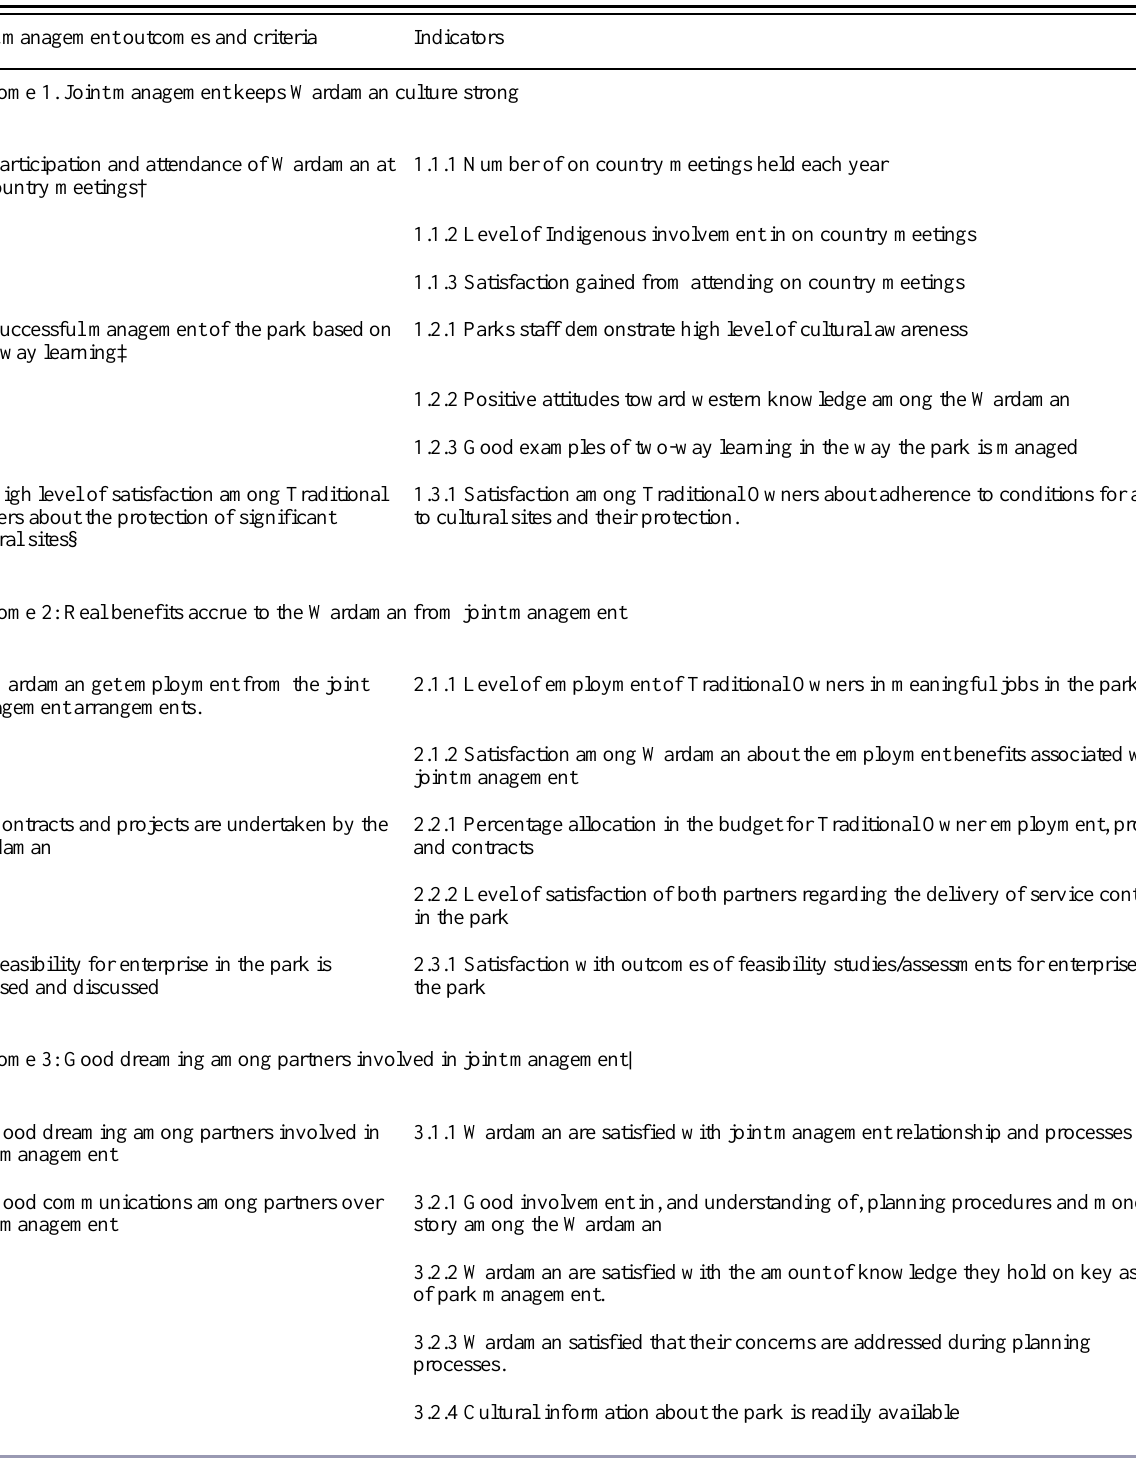
Table 1 . Joint management monitoring and evaluation criteria and indicators for Flora River Nature